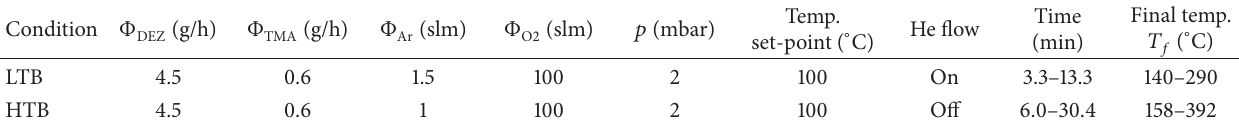
Table 1: The experimental parameters used to deposit ZnO:Al layers at low thermal budget (LTB) and high thermal budget (HTB) conditions. Condition Φ DEZ